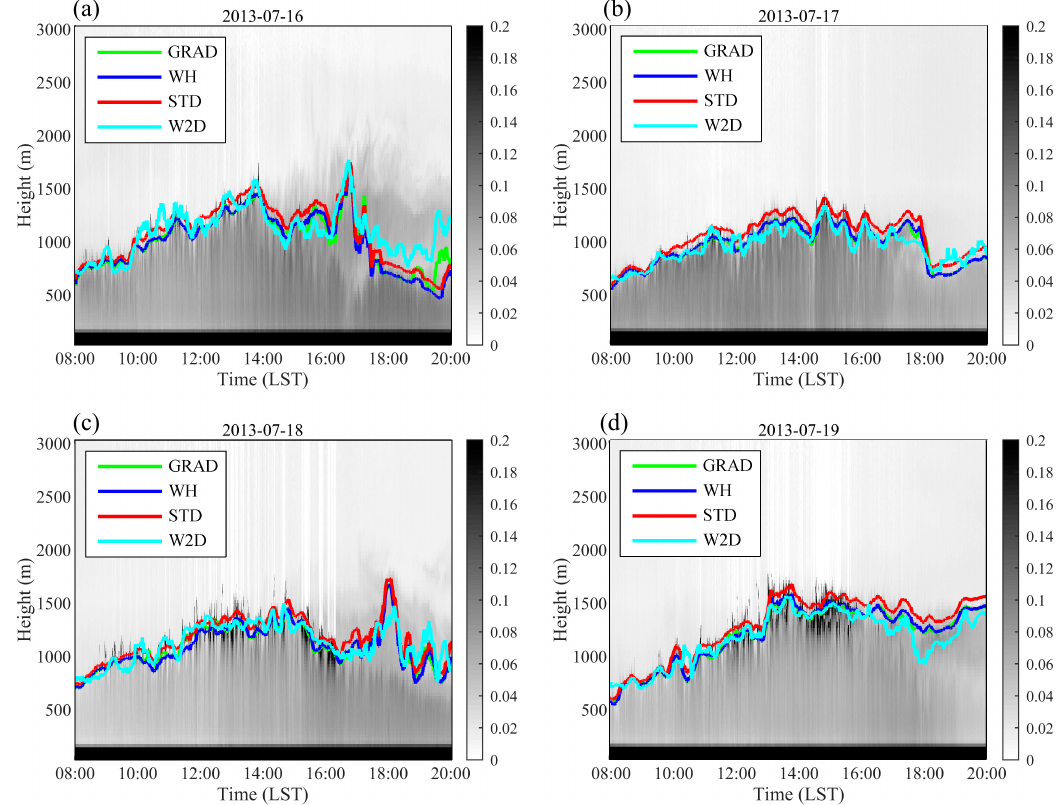
Figure 4. The diurnal variations of ML heights (solid lines) calculated by the 2D wavelet method based on di ff erent wavelet filters: ( a ) 16 July, ( b ) 17 July; ( c ) 18 July, ( d ) 19 July 2013. The grey shades show the extinct coe ffi cients, unit: hm − 1 .